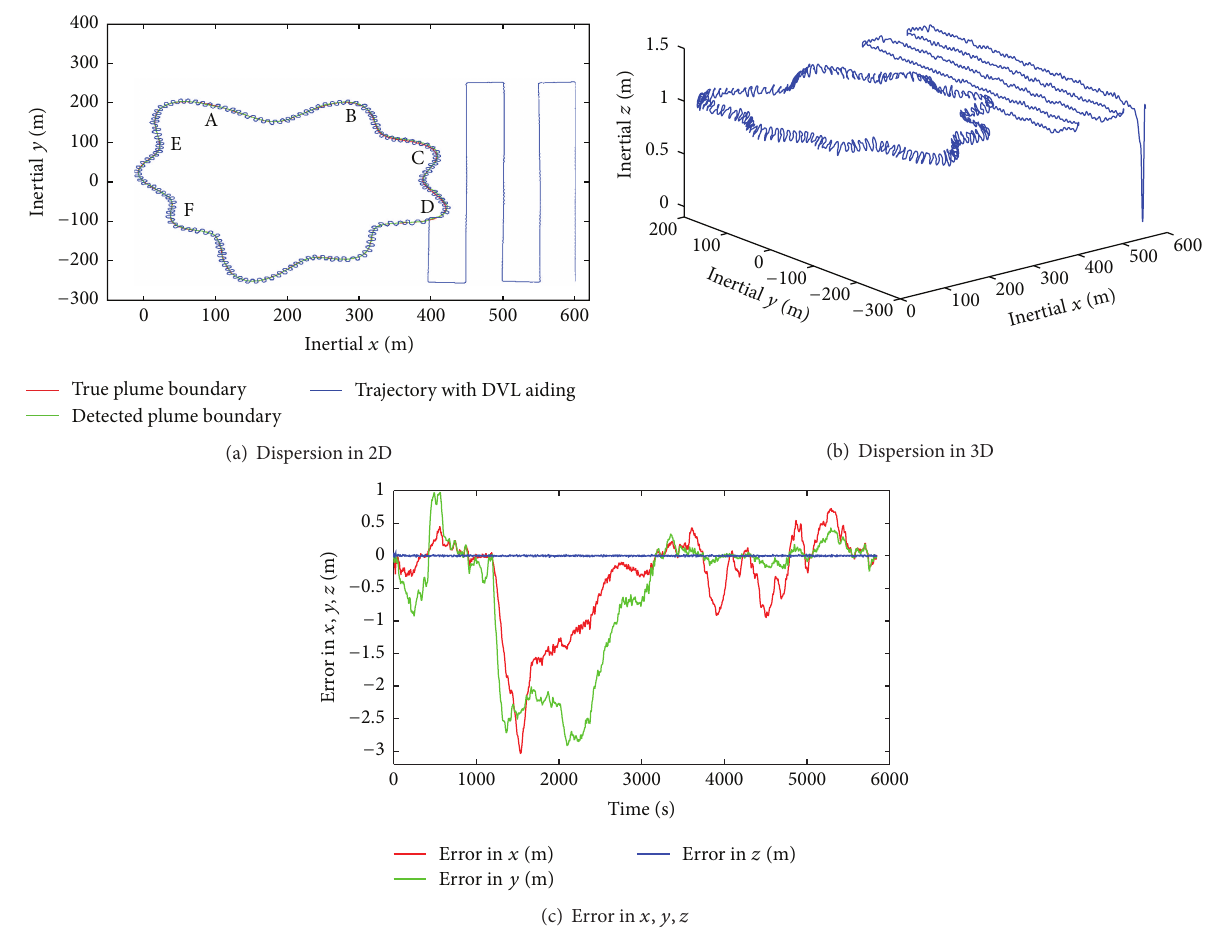
Figure 13: Plume boundary modeled using Fourier